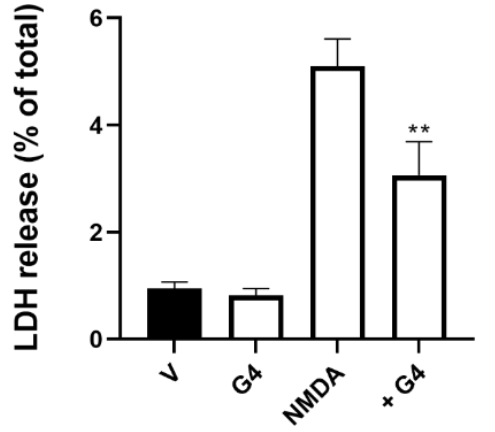
Figure 7. Phosphorous dendrimers prevent NMDA-mediated excitotoxicity in human brain organoids. Brain organoids were treated with either vehicle (V) or G4 phosphorous dendrimers (10 µM) for 1 h, and then NMDA (150 µM) was added and and incubation continued for another 24 h. LDH was determined as indicated in the Materials and Methods section. The data represent the